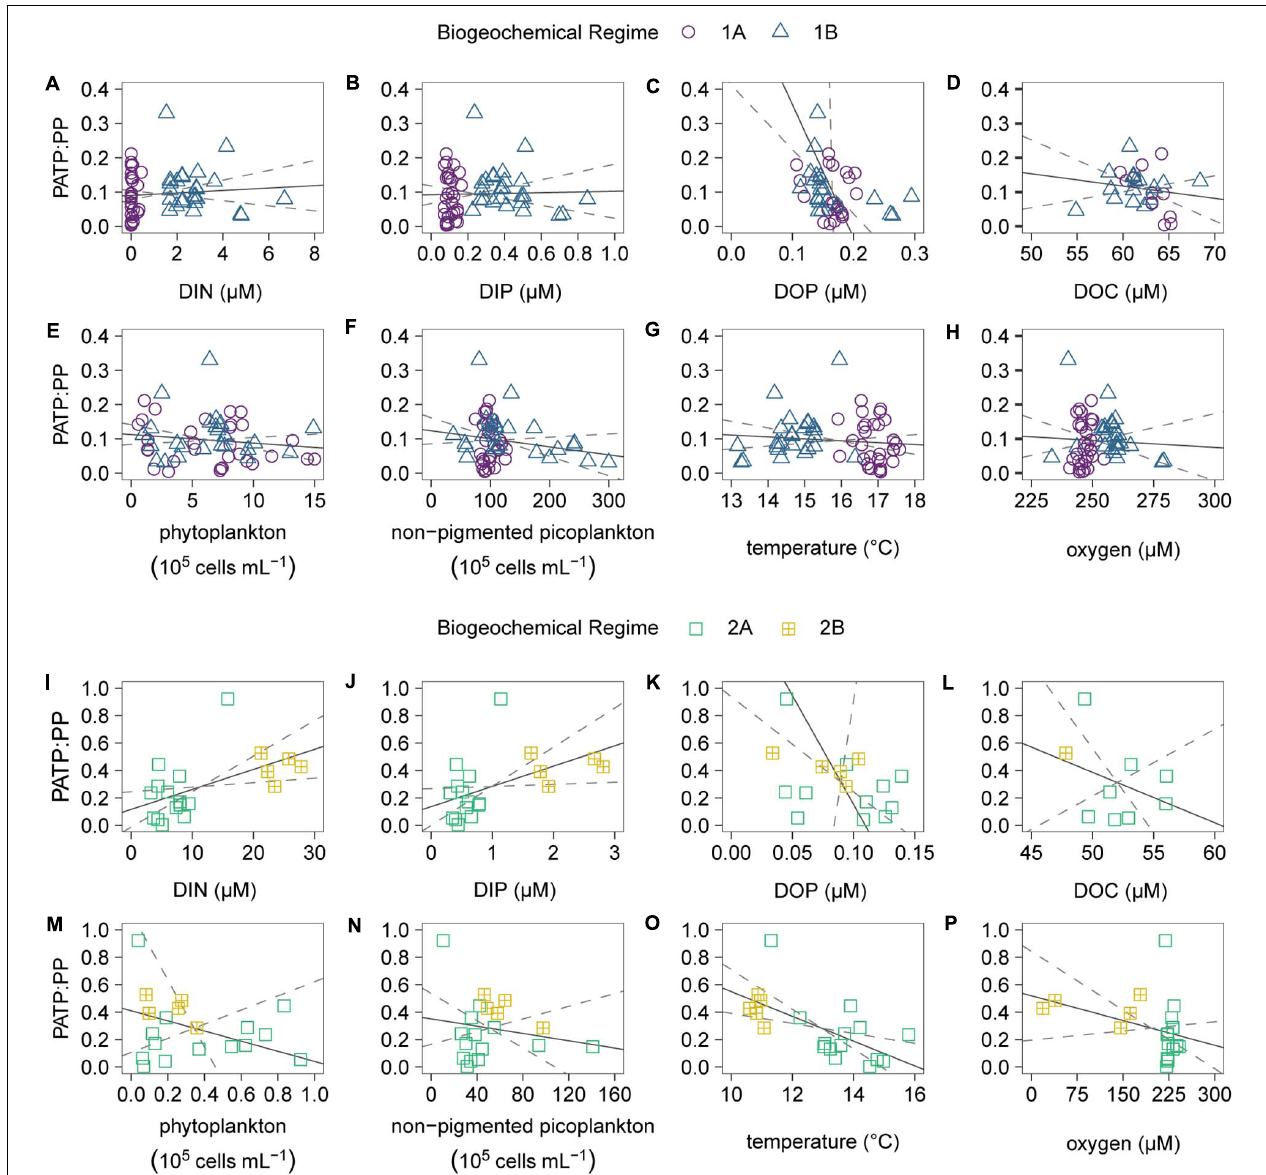
FIGURE 6 | Scatter plots and Model II linear regressions for the combined regimes 1A (purple circles) and 1B (blue triangles) of the particulate ATP normalized to particulate phosphorus (PATP:PP) vs. (A) dissolved inorganic nitrogen (DIN), (B) dissolved inorganic phosphorus (DIP), (C) dissolved organic phosphorus (DOP), (D) dissolved organic carbon (DOC), (E) phytoplankton abundance, (F) non-pigmented picoplankton abundance, (G) temperature, and (H) oxygen. Scatter plots and Model II linear regressions for the combined regimes 2A (green squares) and 2B (yellow squares with crosses) of the PATP:PP ( y -axes) vs. (I) DIN, (J) DIP, (K) DOP, (L) DOC, (M) phytoplankton abundance, (N) non-pigmented picoplankton abundance, (O) temperature, and (P) oxygen. All available data points were utilized for the linear regressions (gray solid lines) and 95% confidence intervals (gray dashed